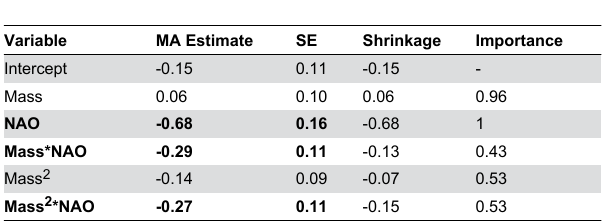
Table 3. Model averaged estimates for the 3 models in theΔ6 AICc top model set remaining after the nesting rule had been applied (see Table 2).